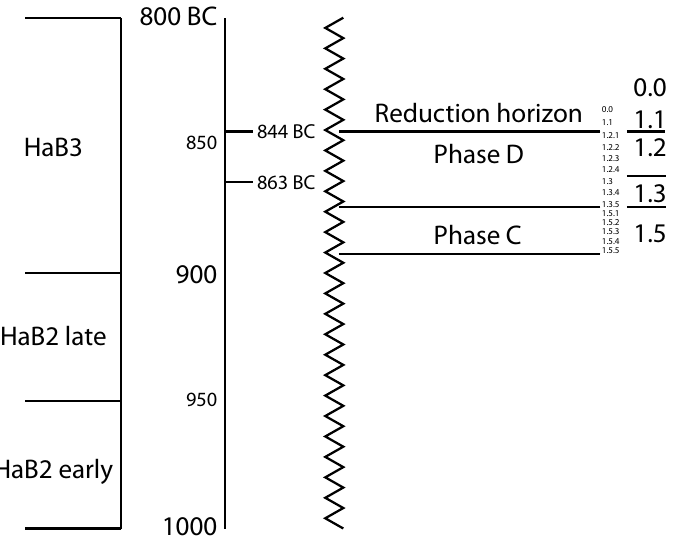
Figure 1. Dating and chronological setting (Hochuli et al. 1998), and phase definition, dendrochronological dates (844 and 863 BC), and stratigraphic layer sequence of Zürich-Alpenquai Phases C and D (after Künzler Wagner 2005). Zigzag line denotes separation of absolute dates and stratigraphic